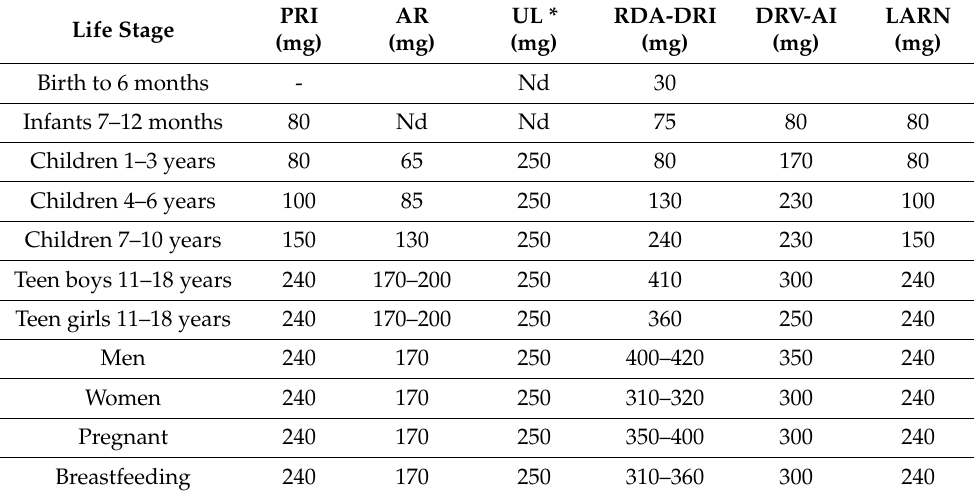
Table 2. Magnesium intake recommendations expressed in terms of: Population Reference Intake (PRI), Average Requirement (AR), Recommended Dietary Allowance (RDAs)—Dietary Reference Intakes (DRIs), Dietary Reference Values (DRVs)—Adequate Intake (AI), “Livelli di Assunzione di Riferimento di Nutrienti ed energia per la popolazione italiana” (LARN) and tolerable Upper intake Level